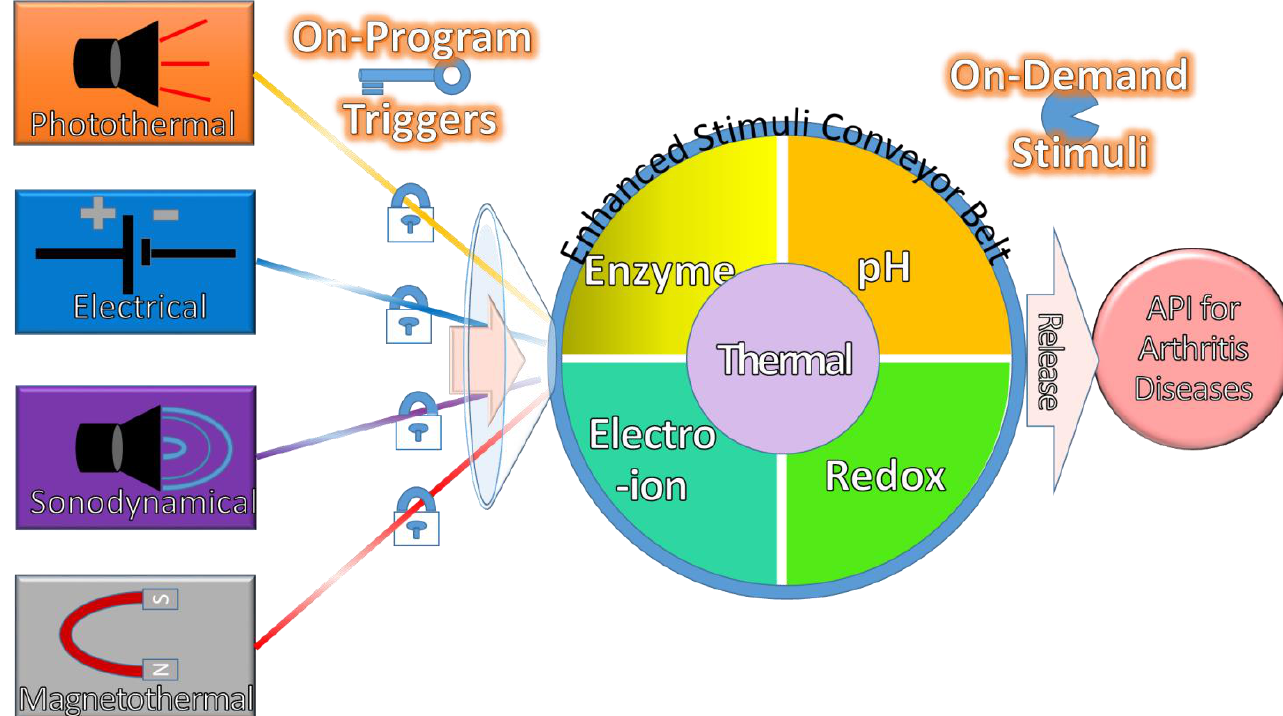
Figure 2. The mechanisms of multiple on-program triggers are enhanced with multiple on-demand stimuli to release API for arthritis diseases.